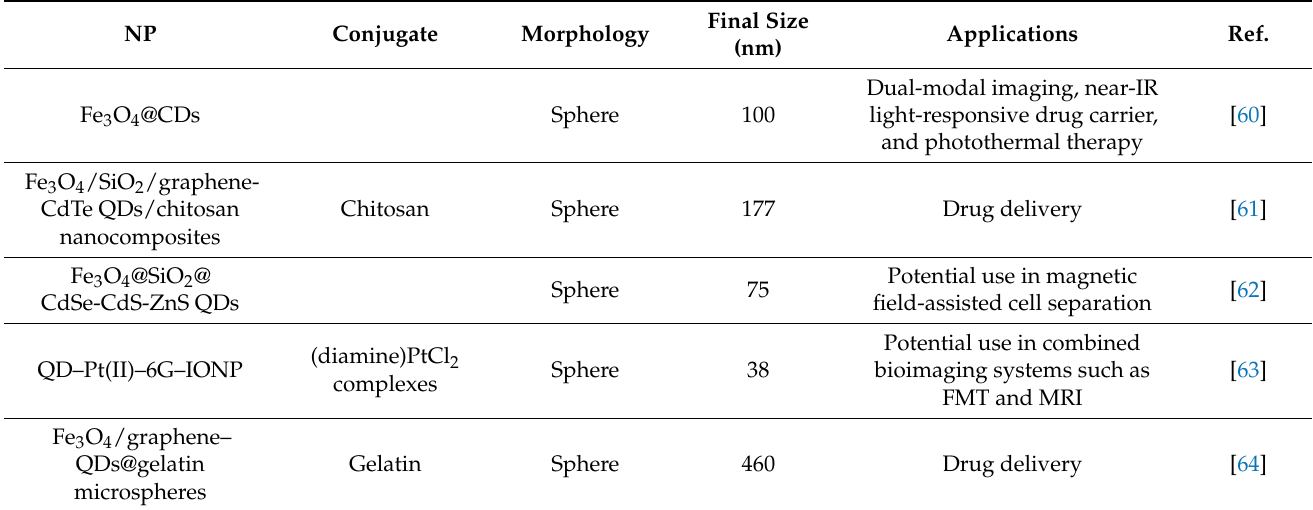
Table 3. Integration of QDs and magnetic iron oxide NPs for biomedical